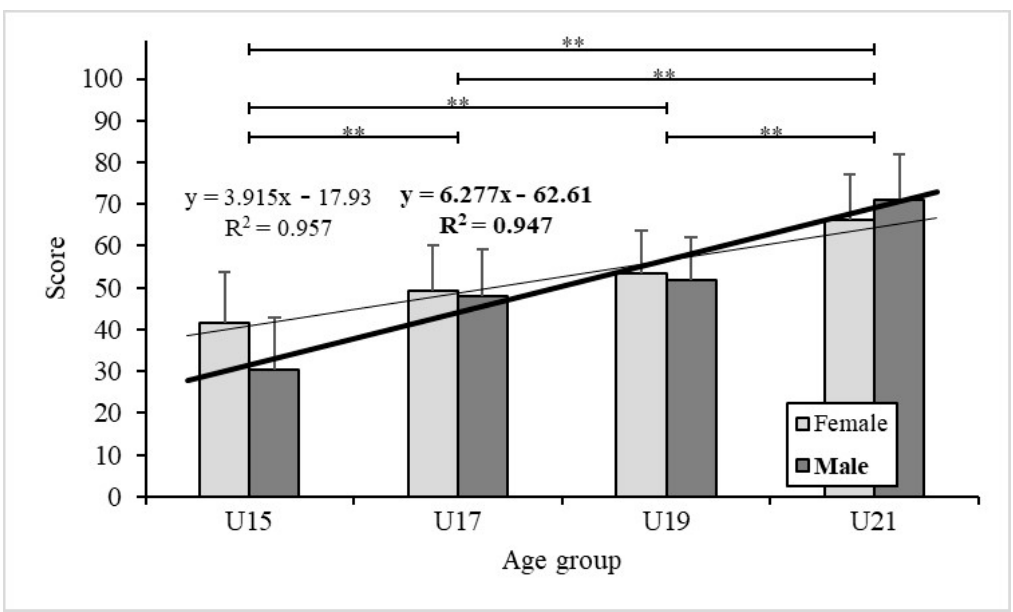
Figure 2. Both genders’ Scores as a function of age group. Significant differences (** p < 0.001) between age groups were the same for both gender samples, so they are illustrated together.